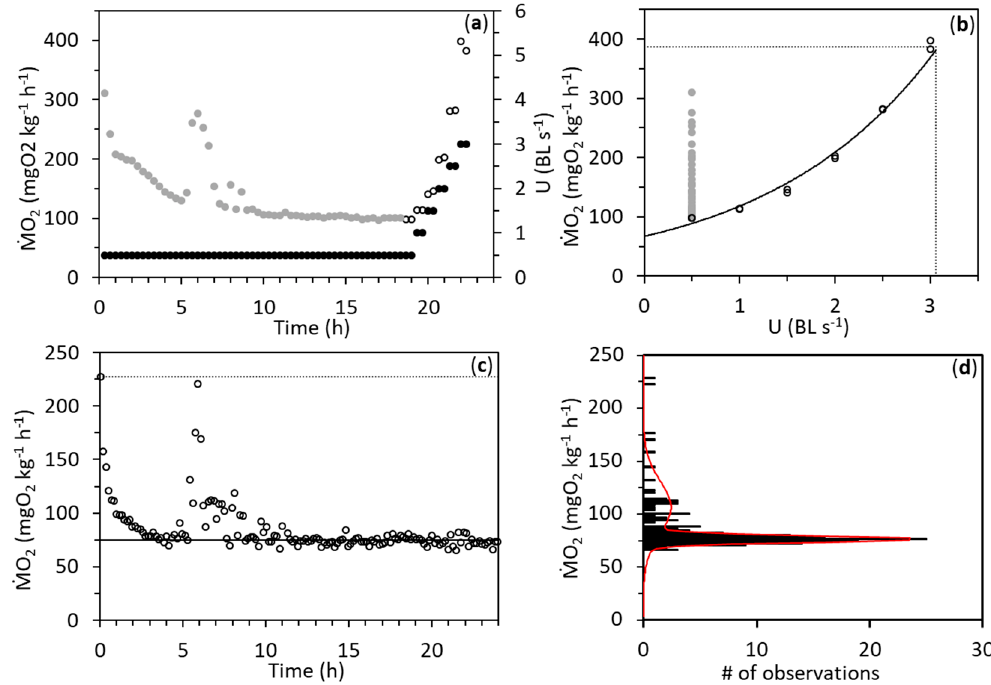
Figure 2. Oxygen consumption rates ( Ṁ O 2 ) of a European perch ( Perca fluviatilis ) of 125 g and 22 cm from a high salinity tolerant population at a salinity of 10. ( a ) Ṁ O 2 over time in a swimming respirometry trial, where swimming speed (U) is given in body lengths (BL) s − 1 . Grey circles represent Ṁ O 2 before a critical swimming speed test, where Ṁ O 2 is represented by open circles. ( b ) Ṁ O 2 from the swimming respirometry trial in relation to U. A two-parameter exponential function was fitted to Ṁ O 2 vs. U during the U crit test (solid line). Standard metabolic rate (SMR) was estimated by extrapolating this fit to a swimming speed of 0.0 BL s − 1 and maximum metabolic rate (MMR) estimated by extrapolating the fit to the critical swimming speed (dashed lines). ( c ) Ṁ O 2 of the fish over time in a static respirometer (open circles), where the solid line indicates SMR and the dashed line indicate MMR. ( d ) Histogram of the Ṁ O 2 during the static respirometry trial (black columns; bins = 2 mgO 2 kg − 1 h − 1 ). A double Gaussian distribution was fitted to the Ṁ O 2 histogram (red line), sorting SMR determined into the distribution with the lowest mean value, and spontaneous activity into the other.